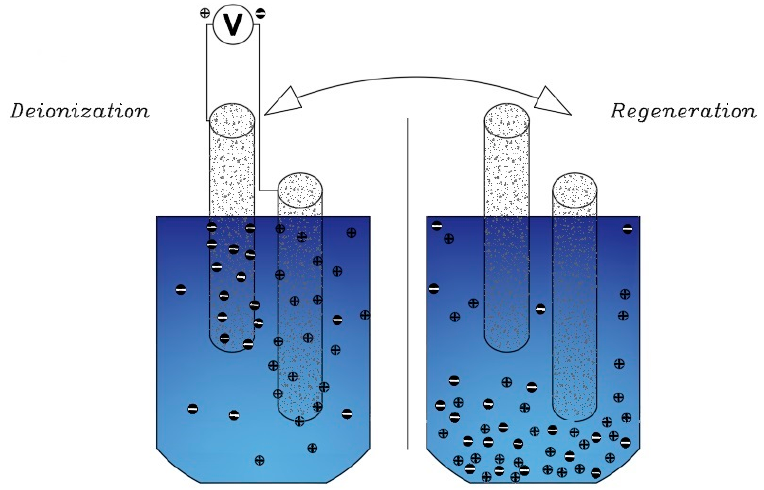
Figure 6. Installed electrostatic ion pumping in a CDI cell.